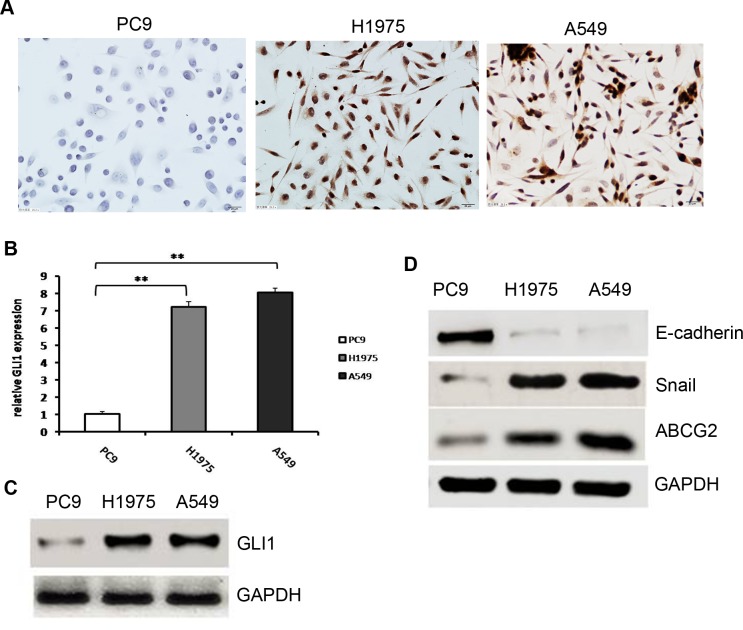
Hh pathway activity in EGFR-TKI-sensitive and -resistant cells.(A). Differences in GLI1 expression in EGFR-TKI-sensitive and -resistant NSCLC cells determined with immunocytochemistry. GLI1 was expressed in the nuclei of EGFR-TKI-resistant cell lines A549 and H1975, but GLI1 expression was negative in the EGFR-TKI-sensitive cell line PC9. (B). Relative GLI1 mRNA expression in EGFR-TKI-sensitive and -resistant NSCLC cells determined by Q-PCR; The expression of PC9 was significantly lower than that of H1975 and A549; ** (P<0.01). (C). Differences in GLI1 expression in EGFR-TKI-sensitive and -resistant NSCLC cells determined by western blot. (D) Differences in E-cadherin, Snail, and ABCG2 expression in EGFR-TKI-sensitive and -resistant NSCLC cells determined by western blot.